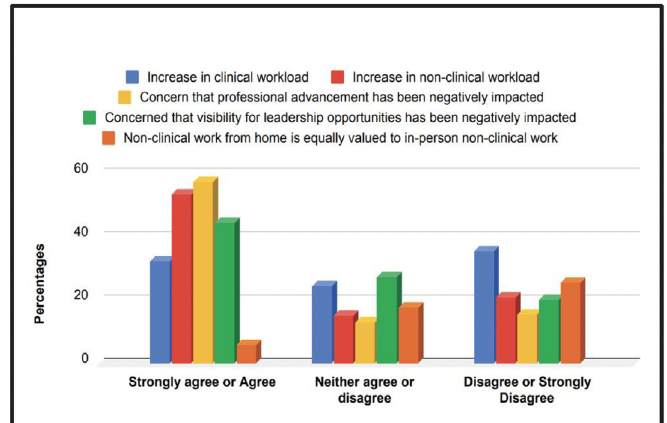
Figure 2. Professional impact of the COVID-19 pandemic.